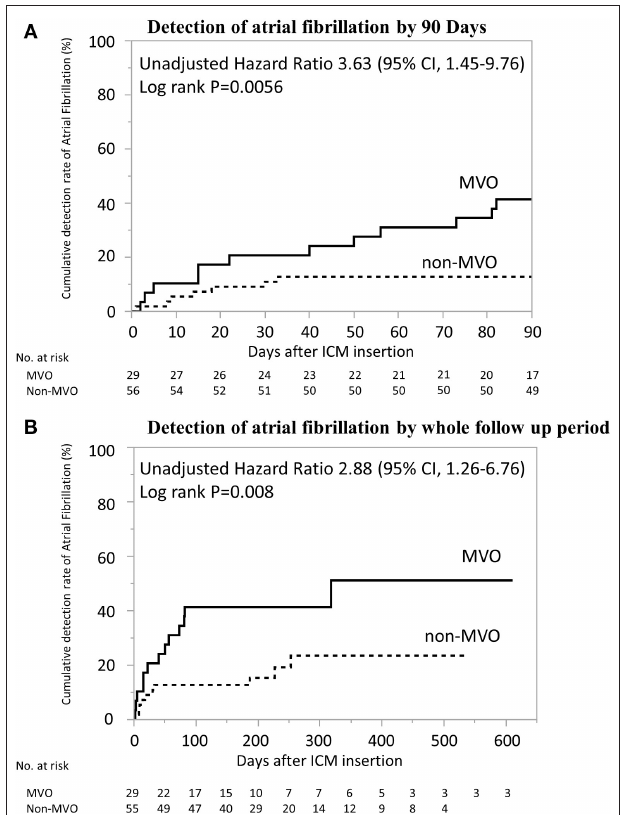
FIGURE 2 | Kaplan–Meier Estimates from ICM Implantation to AF Detection. Days from implantation of insertable cardiac monitoring to AF detection was significantly shorter in patients with MVO than in those without (log-rank p < 0.01). (A) Detection of atrial fibrillation by 90 days. (B) Detection of atrial fibrillation by whole follow up period. AF, atrial fibrillation; ICM, insertable cardiac monitoring; MVO, major vessel